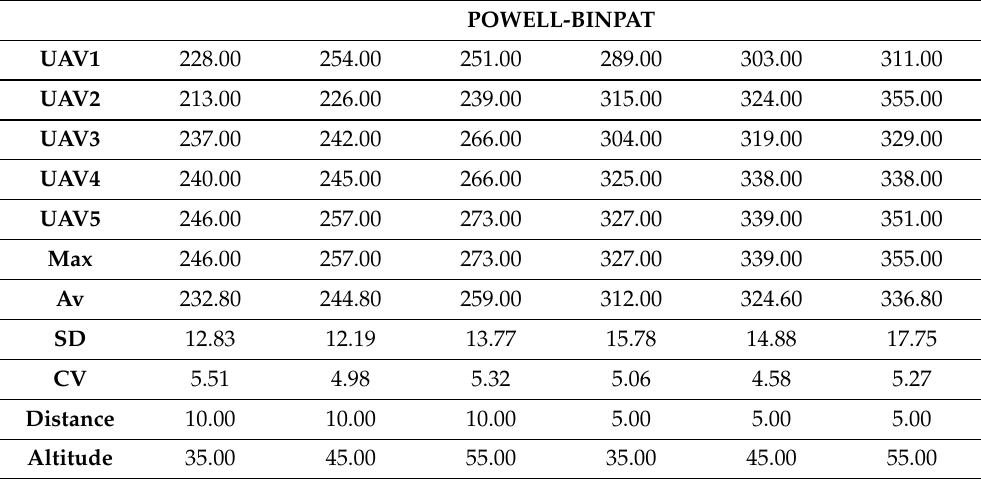
Table A6. Time results using the POWELL-BINPAT algorithm and five UAVs in a short-track